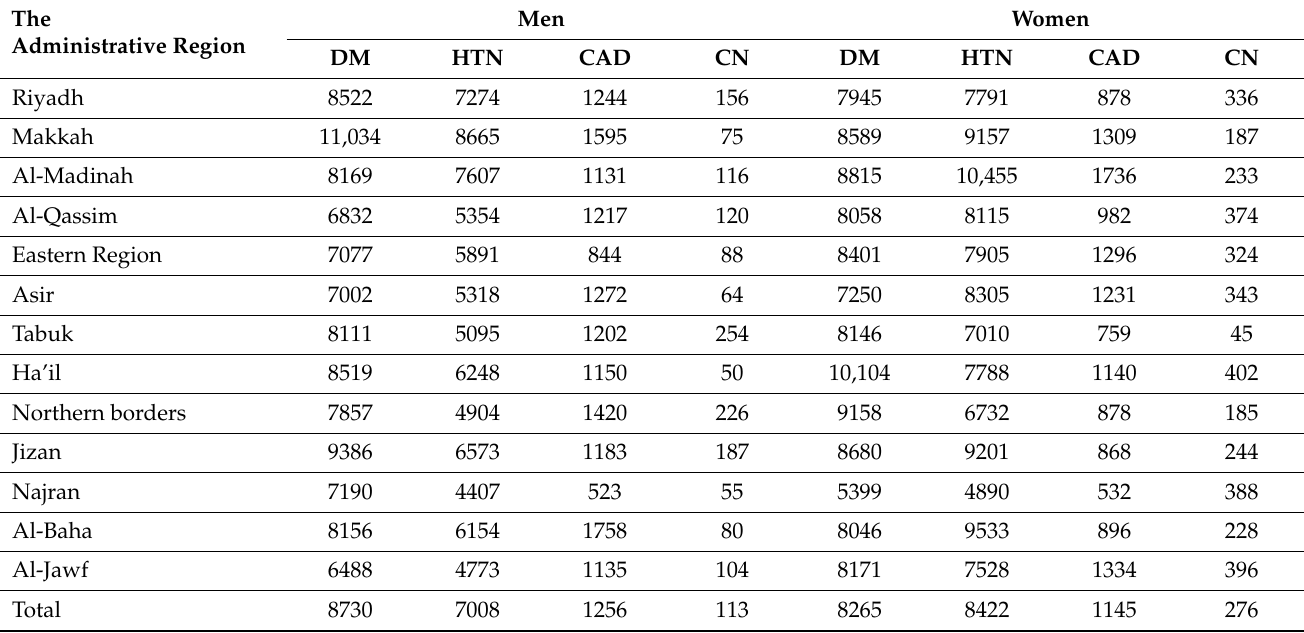
Table 2. The rates of chronic diseases in the total population by gender and the administrative region.